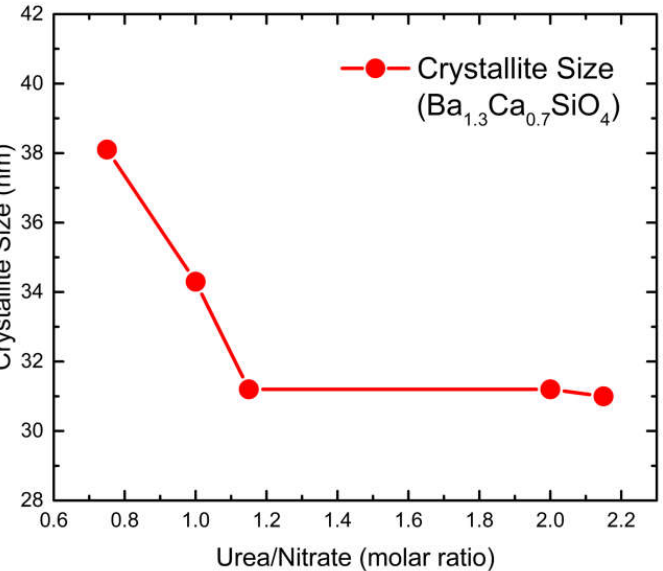
Figure 4. Crystallite size of τ -phase Ba 1.3 Ca 0.7 SiO 4 powder samples as a function of the molar ratio of metal nitrate:urea.